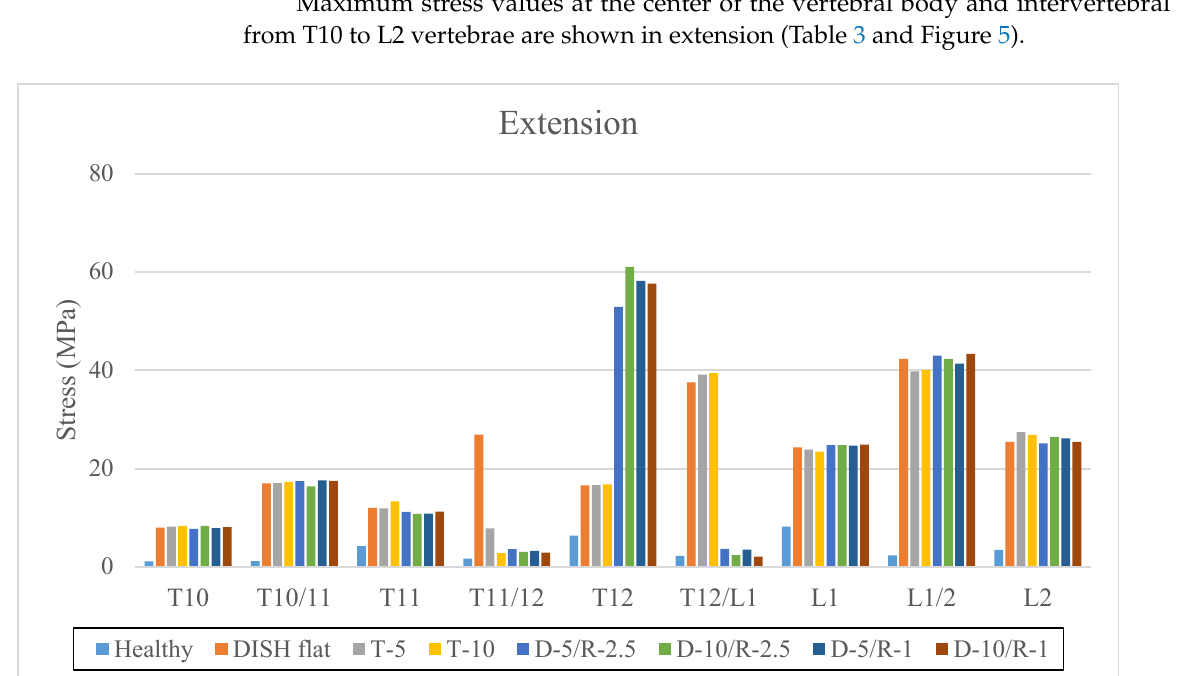
( b ) Figure 6. Only vertebral bodies and discs are shown for clarity. The right bar is color-coded accord- ing to stress (MPa). Stress diagrams of ( a ) the healthy model and ( b ) the diffuse idiopathic skeletal hyperostosis (DISH) flat model. Stresses were greater in the flat model in extension than in the healthy model. In the T-5 model and T-10 model, the stress on the vertebral body was similar with greater ossification in extension (Figure 7). As the thickness of ossification increased, stress on the intervertebral disc decreased.